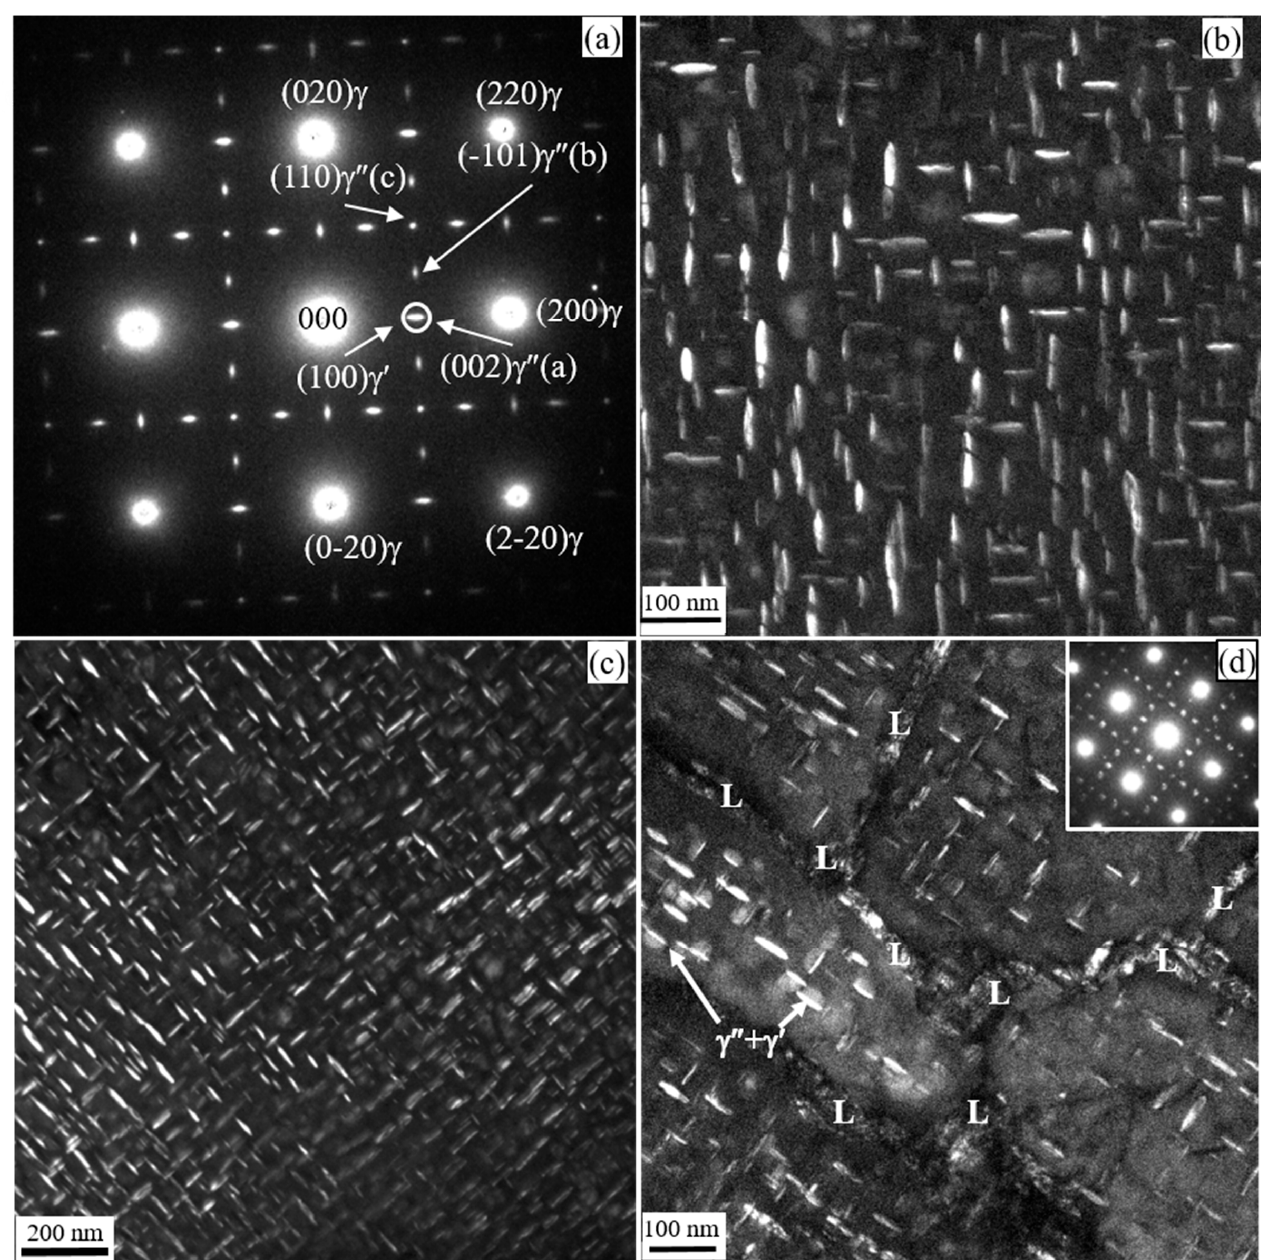
Figure 6. TEM images of aged samples: ( a ) SAD in [001] zone ( b ) DF image of STA16 using the circled superlattice spot in ( a ), ( c ) DF image of STA9 and ( d ) DF image of DA. The inset in ( d ) is the corresponding diffraction pattern of the image. The subgrain boundary regions with undissolved Laves and lattice defects are indicated by the letter ‘L’ in ( d ). The labels ( a ), ( b ), and ( c ) in the SAD in ( a ) refer to the orientations of [001], [010], and [001], respectively. Direct Aging